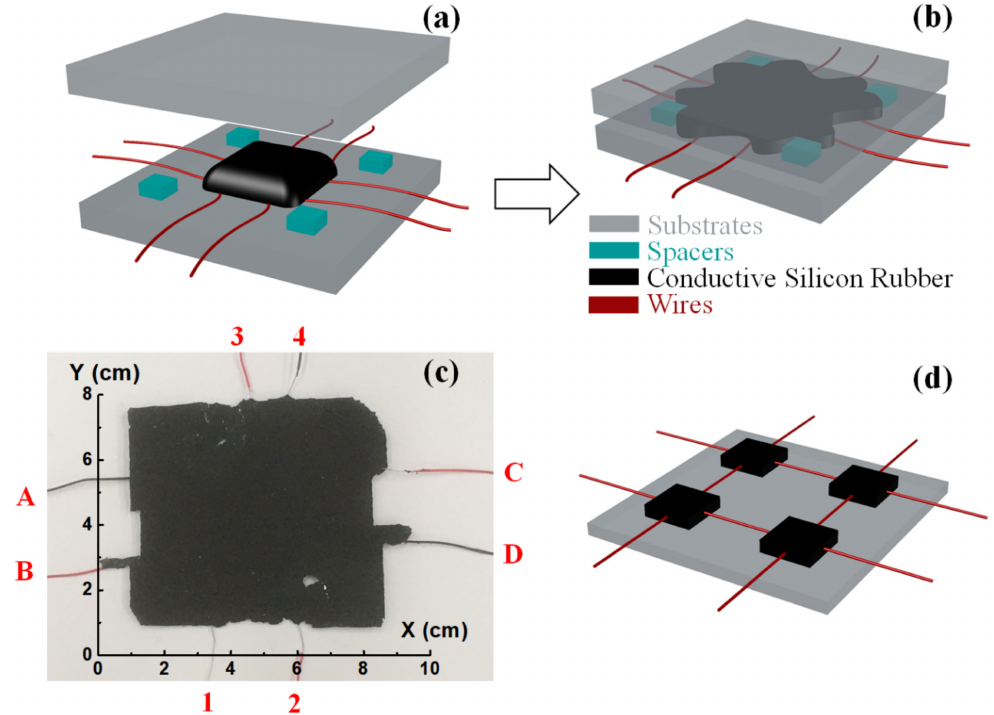
Figure 1. ( a ) Conductive rubber solution was dropped onto the center of the template, and 8 electrodes were embedded into the conductive rubber; ( b ) the conductive rubber was compressed into an irregularly-shaped planar structure; ( c ) picture of the fabricated sample with embedded and numbered